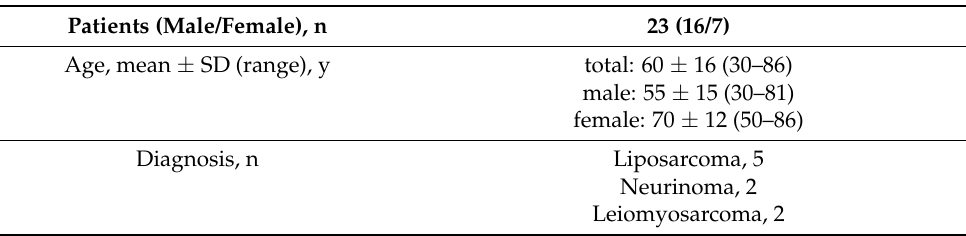
Table 3. Patient